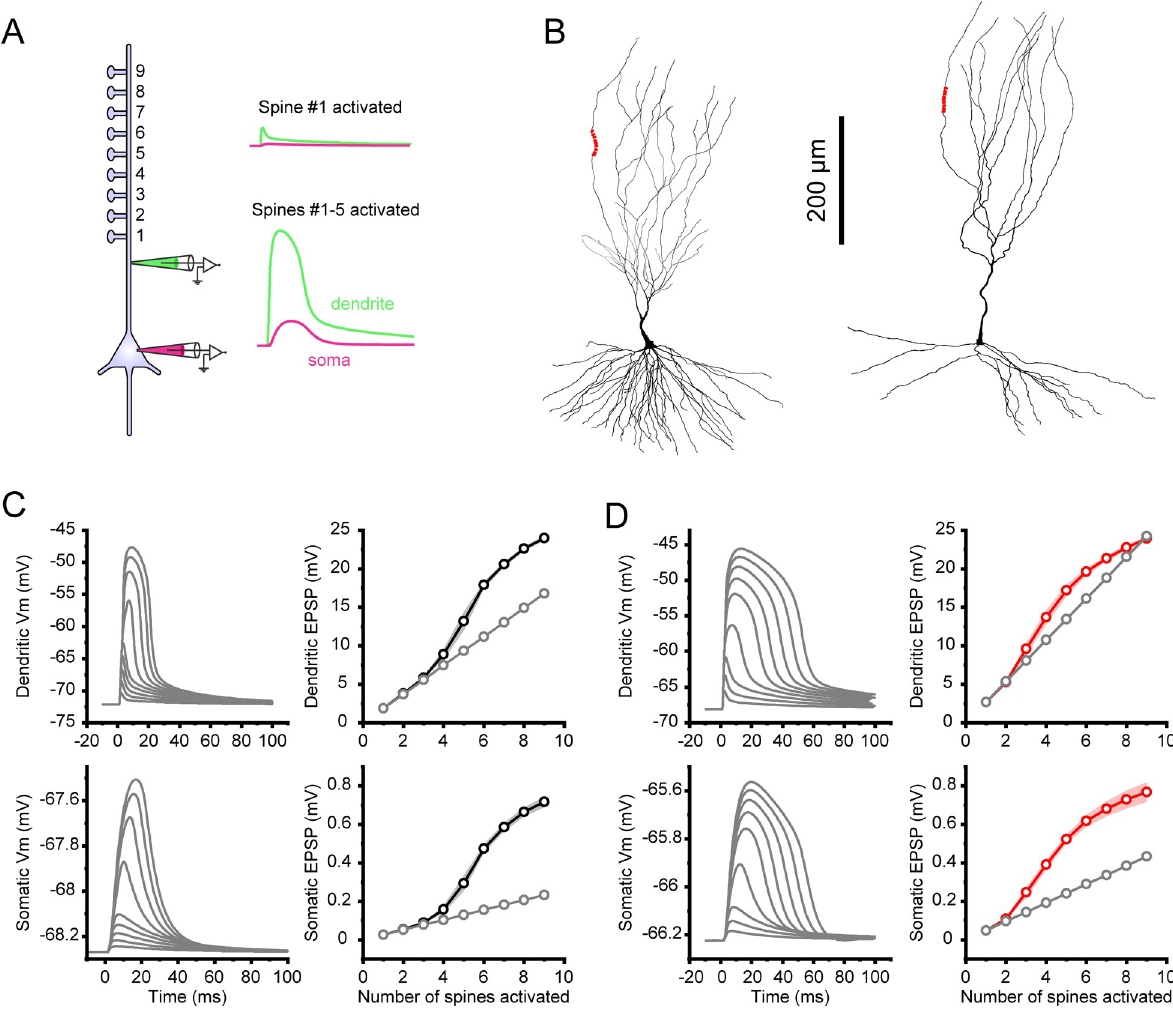
Fig 5. Cooperativity and nonlinear amplification of synaptic input in cell type specific models. (A) Schematic of the experimental setup: 9 spines were placed on an apical branch and stimulated sequentially by the arrival of presynaptic spikes with a time interval of 0.3 ms. Each spine contained AMPA and NMDA synapses, whose parameters were adjusted to lead to a voltage deflection at the spine head of approximately 20 mV. The spine EPSP then propagated to the dendritic trunk and soma (example voltage traces shown on the right) when one or multiple spines were activated. (B) Location of the spines (red dots) on the apical branch of a thorny (left) and an a-thorny cell (right). (C) Vm traces recorded in the dendritic trunk (top left) and at the soma (bottom left) and corresponding EPSP peak amplitudes (right, black markers) in response to increasing numbers of presynaptic inputs in the thorny cell shown in (B, left). Grey markers indicate the linear prediction obtained by multiplying the amplitude of the EPSP in response to a single input by the number of presynaptic inputs. (D) Same as (C) but for the a-thorny cell shown in (B, right).